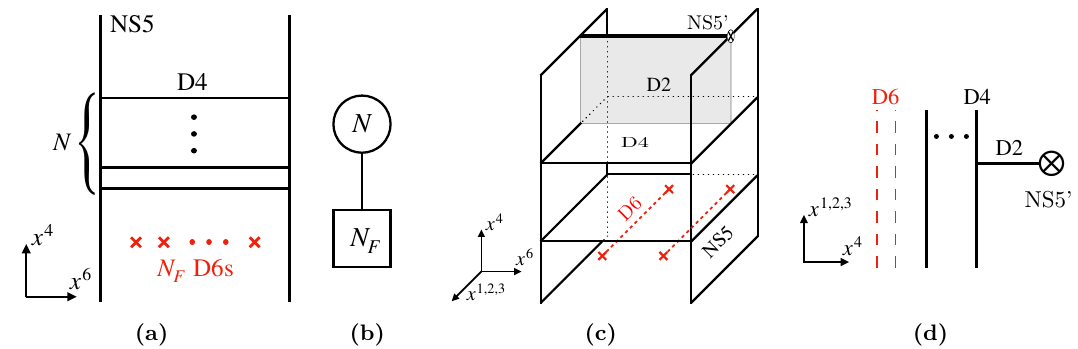
Figure 1. (a): the brane configuration for the 4d N = 2 SQCD. The ( x 4 , x 6 ) -directions are shown explicitly. (b): the 4d N = 2 quiver diagram corresponding to (a). A circle with N means the U( N ) vector multiplets and a solid line represents a hypermultiplet in the fundamental